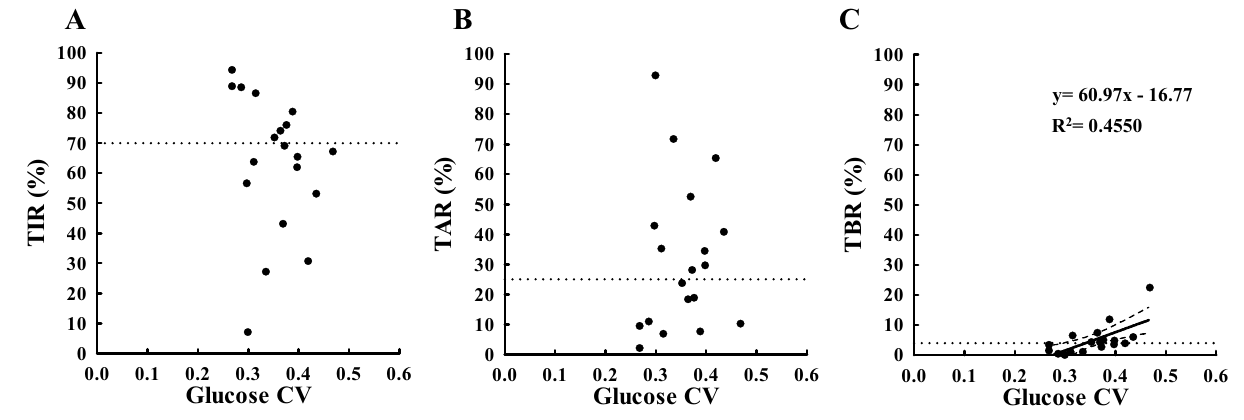
Figure 3. Scatterplot indicating the relationship between glucose CV (x-axis) and CGM-related metrics (TIR ( A ), TAR ( B ), and TBR ( C ); y-axis) measured within 120 days from baseline. The solid line is the line of best-fit from the linear regression analysis. The dashed band is the 95% confidence band of the best-fit line. The dotted horizontal lines represent a TIR of 70% ( A ), a TAR of 25% ( B ), a TBR of 4% ( C ): these values are based on the targets of TIR, TAR, and TBR for adults with type 1 or type 2 diabetes from recommendations of the ATTD 2019 consensus statement. TIR time in range (glucose 70–180 mg/dL), TAR time above range (glucose ≥ 181 mg/ dL), TBR time below range (glucose ≤ 69 mg/dL), R 2 coefficient of determination.